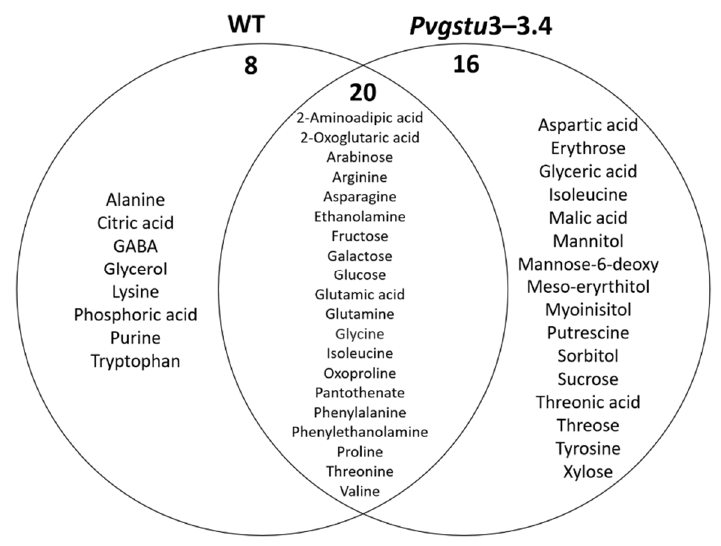
Figure 7. Venn diagram representation of metabolites commonly or differentially increased in the leaves of WT and Pvgstu 3–3.4 tobacco plants grown for 9 days under combined drought and heat stress (DT) compared to stress-free plants.